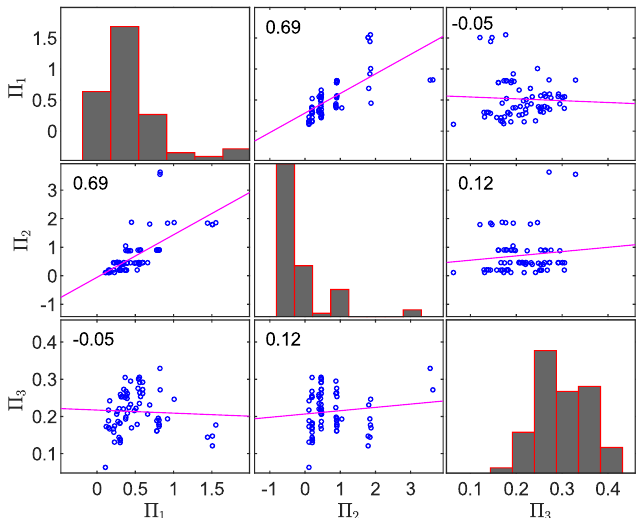
Figure 12. Correlation matrix of explanatory variables Π 1 , Π 2 , and Π 3 in Equation